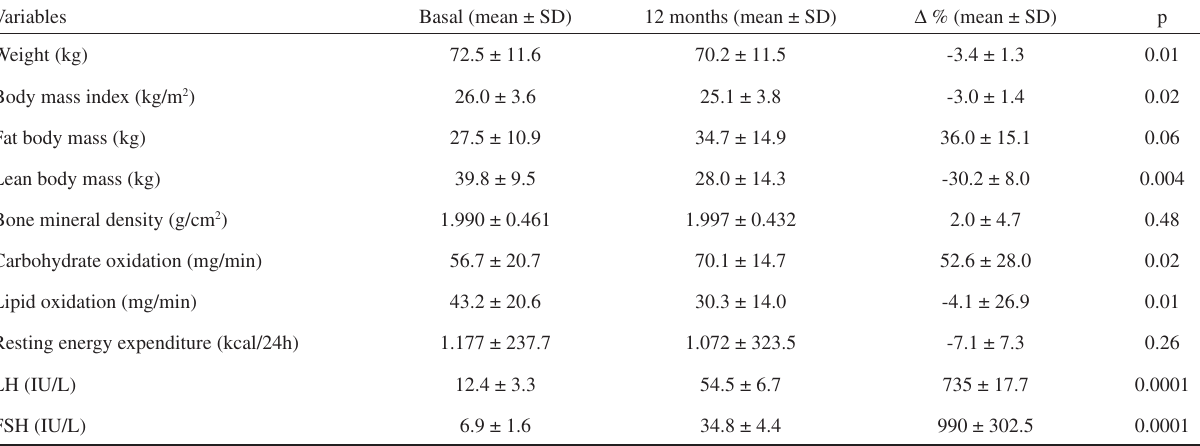
Table 1 - Mean values of variables at baseline and 12 months after orchiectomy